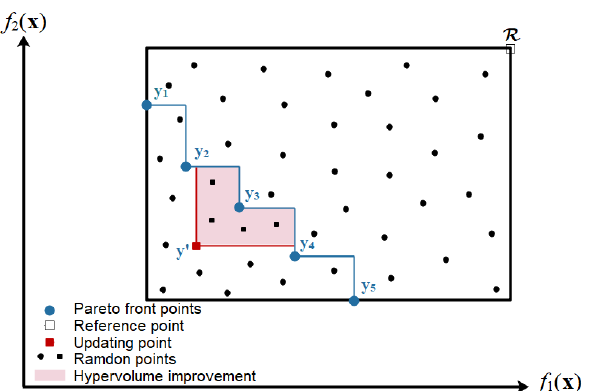
Figure 3. Example of HVI calculation by the Monte Carlo-based method with two objectives.